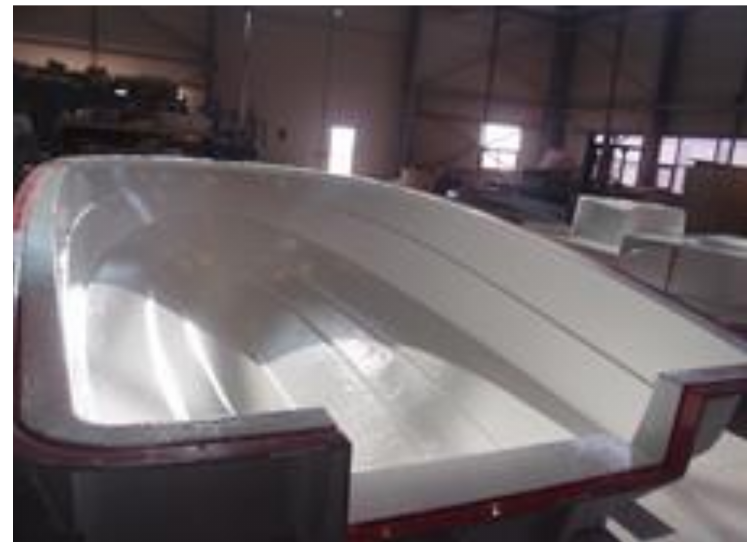
Figure 14. Application of gelcoat.